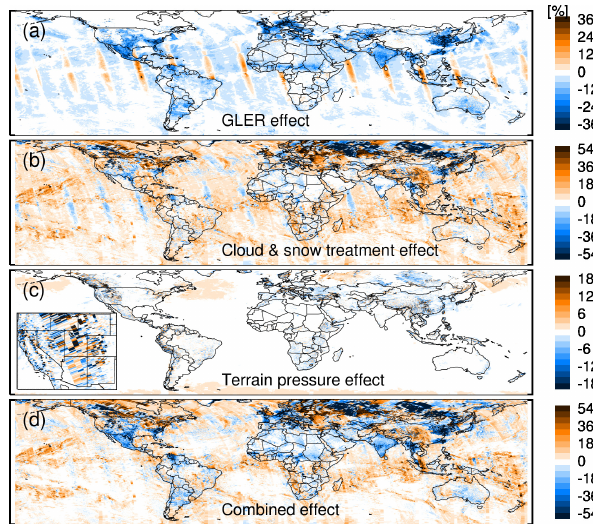
Figure 5. Impact on tropospheric AMF (i.e., V4.0–V3.1) from changes in (a) surface reflectivity, (b) cloud and surface treatment, (c) terrain pressure, and (d) their combination on 20 March 2005. The panel (c) inset shows a zoomed view of the impact over com- plex terrain in the western